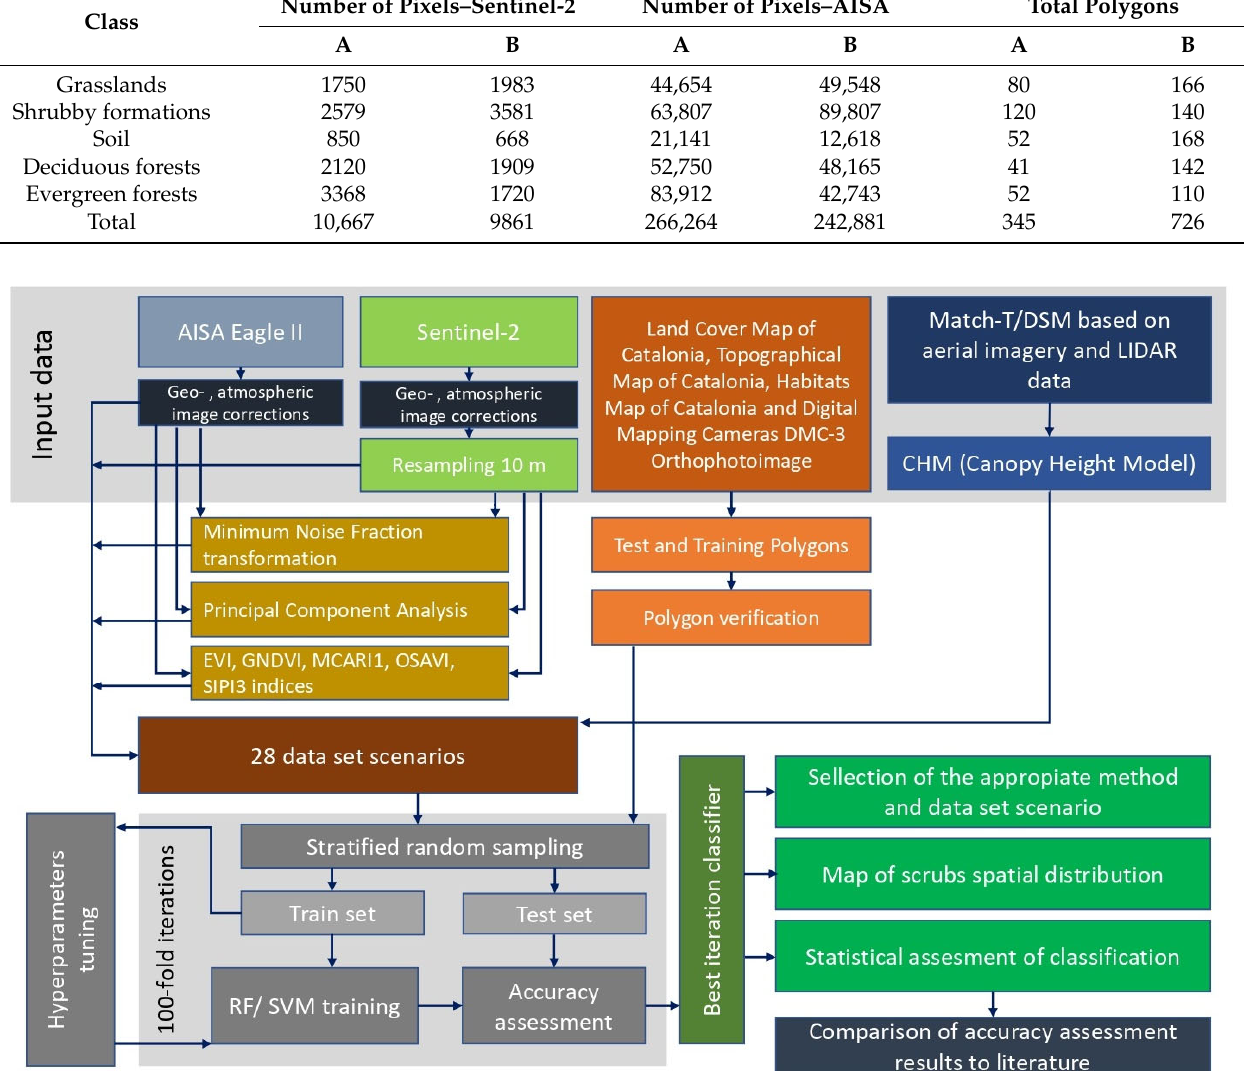
Table 2. Number of field-verified pixels for the polygons of the areas A and B.